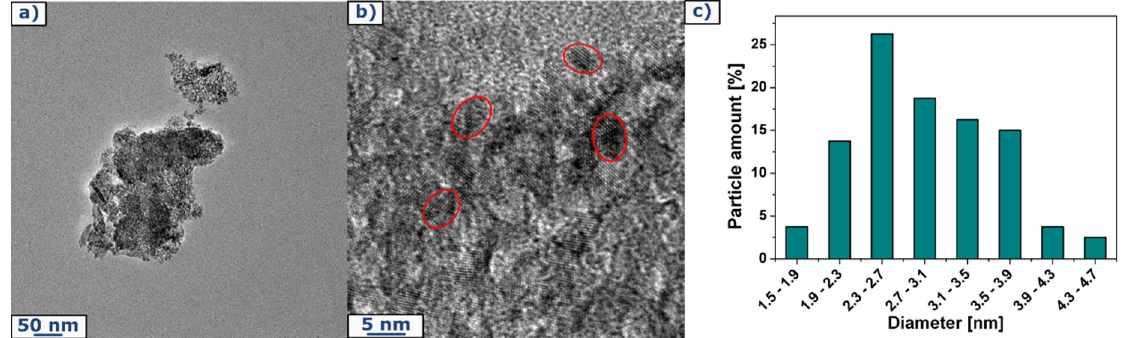
Figure 1. ( a , b ) Transmission Electron Microscope image of TiO 2 and ( c ) corresponding particle size distribution